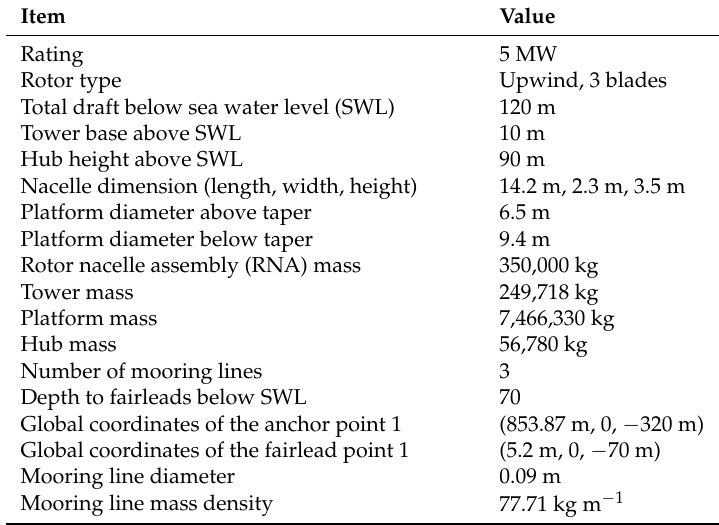
Table 2. Main properties of the OC3-Hywind model.